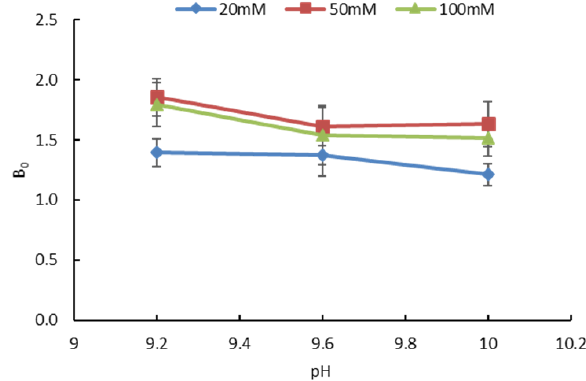
Figure 2: Effect of pH and concentrations of carbonic acid buffer on B value ( n =3). 0